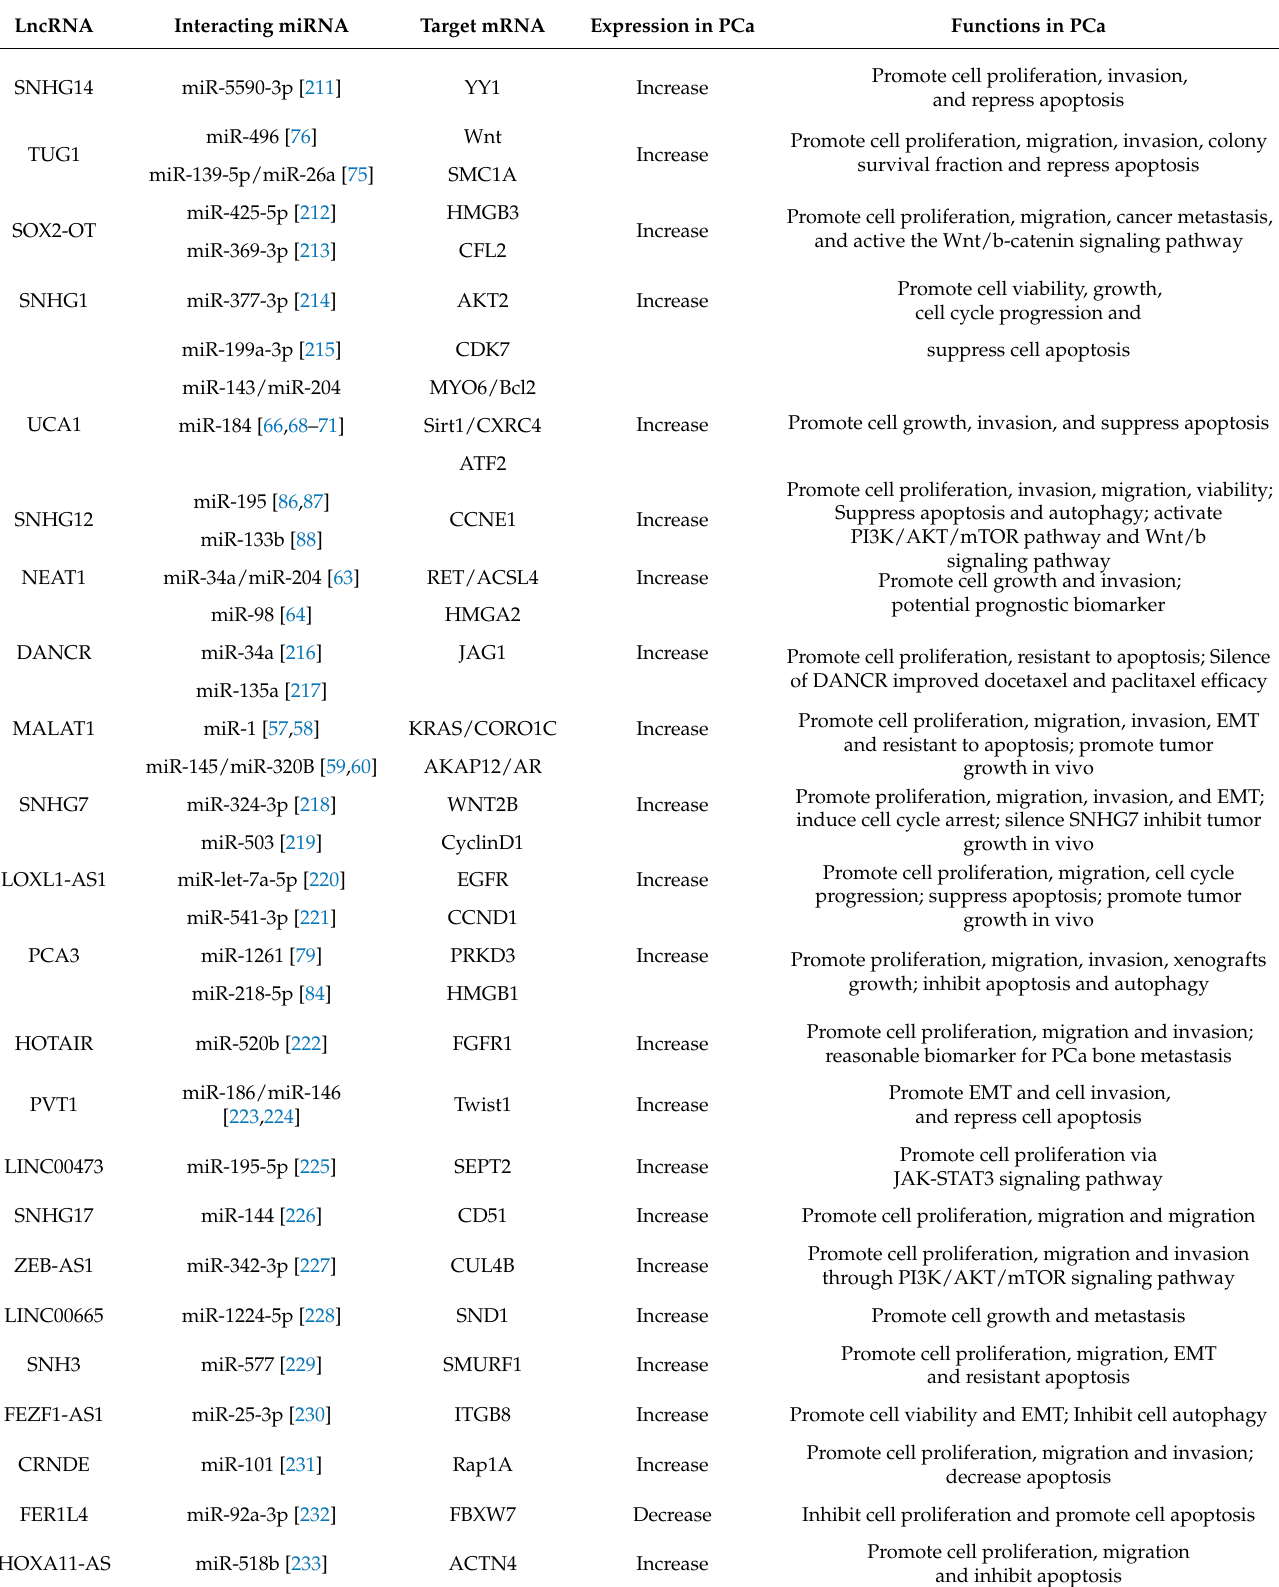
Table 1. LncRNA: miRNA interactions in prostate cancer and their phenotypic